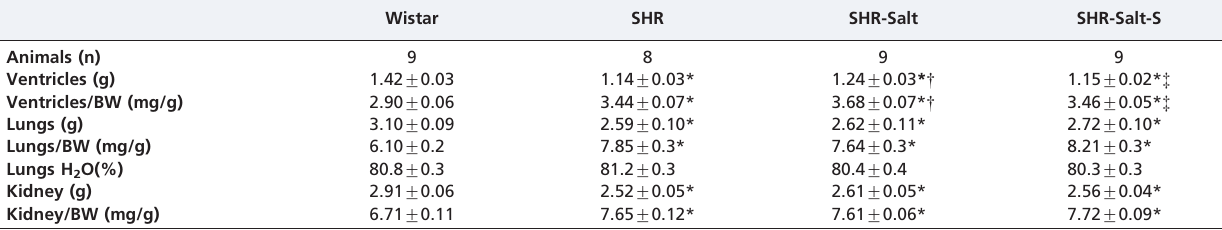
Table 1 - Morphometric parameters measured after eight weeks of treatment.